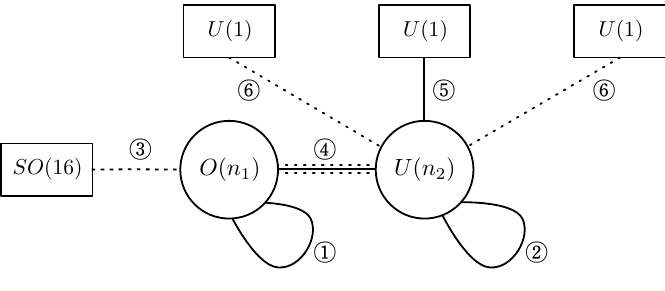
Figure 15 . (0,2) quiver for two small E